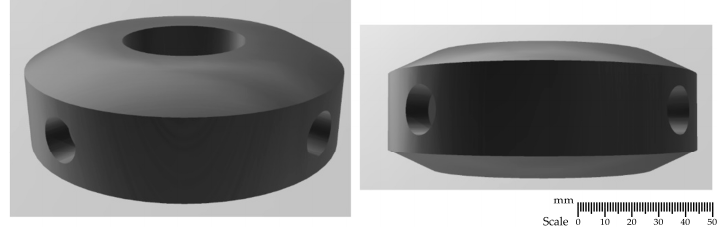
Figure 1. A 3D model—impeller with four holes—variant B4.